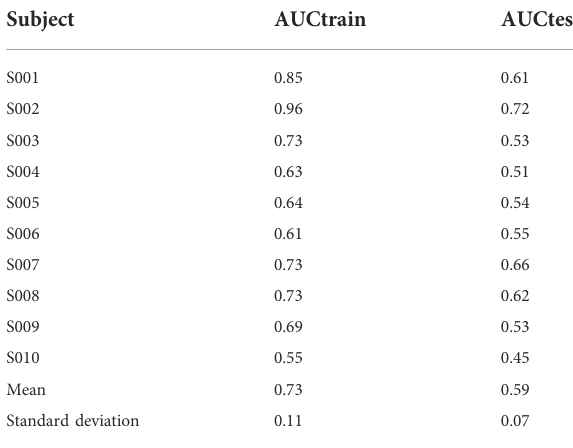
TABLE 3 AUC index of ERP detection obtained from 10 healthy